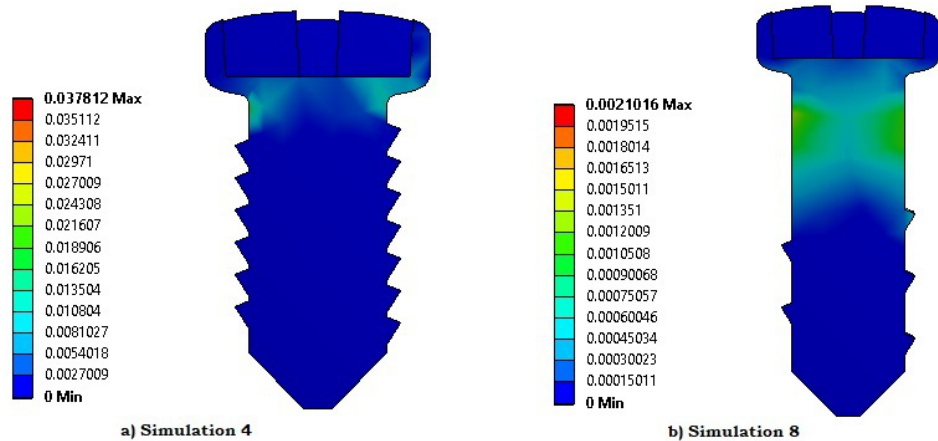
Figure 5. Strain distribution in screw for ( a ) Simulation 4, and ( b ) Simulation 8.